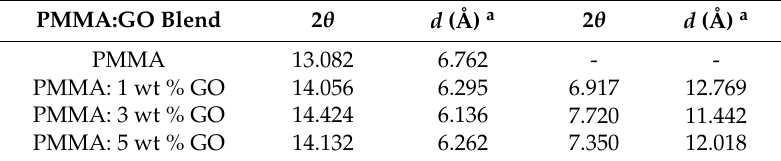
Table 1. XRD results for PMMA and its nanocomposites.